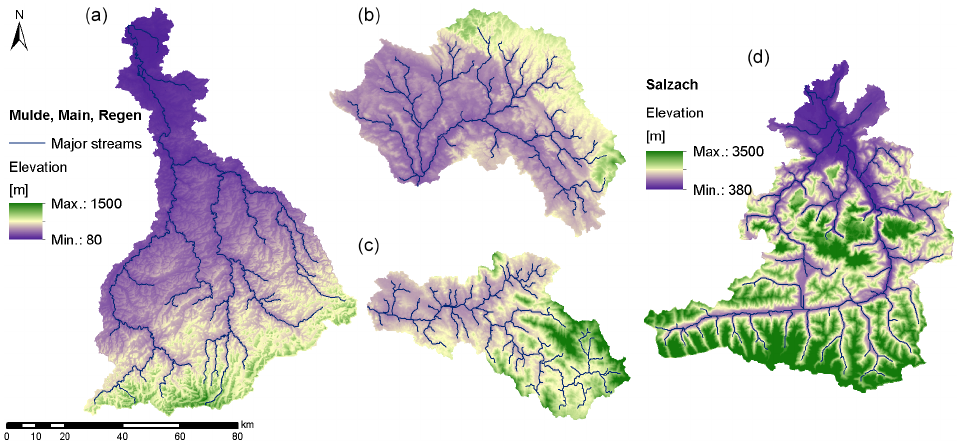
Figure 1. Digital elevation models of the Mulde (a) , upper Main (b) , Regen (c) , and Salzach (d) .